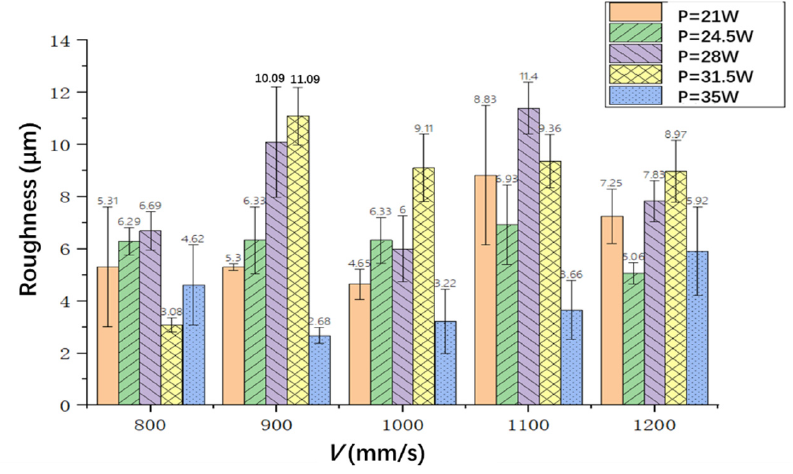
Figure 8. The surface roughness with different laser powers and scanning speeds.